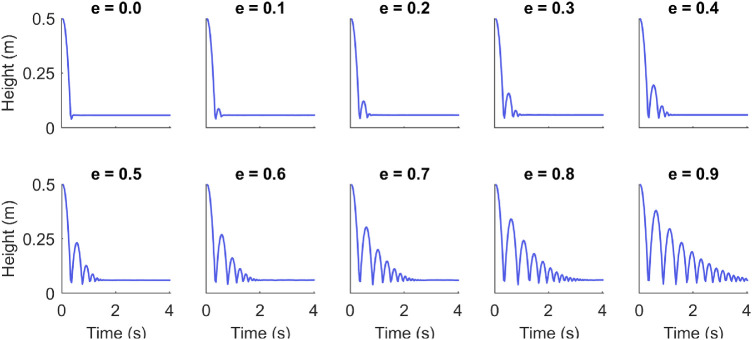
Height of spheres with different elasticities dropped from a height of 0.5 m over 4 s. Data show the height of the CoM of the spheres, which had a diameter of 0.124 m. Therefore, the height never reaches zero. The height of the first bounce was used to calculate an approximation of the coefficient of restitution. Note also that the exponential envelope of the curves (decay) is also consistent with ideal physical behavior.